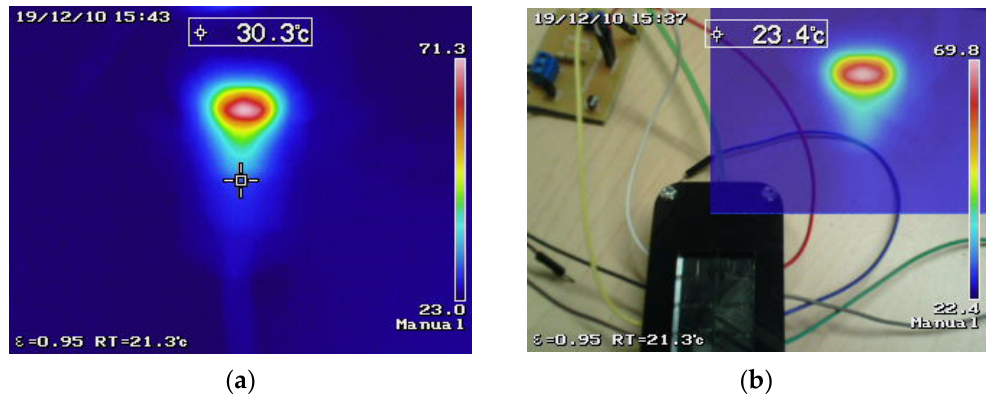
Figure 9. Thermographic camera captures with a controlled flow of 12 mL/h: ( a ) full-screen capture; ( b ) capture in a combined photo that shows the microsystem focalized area.